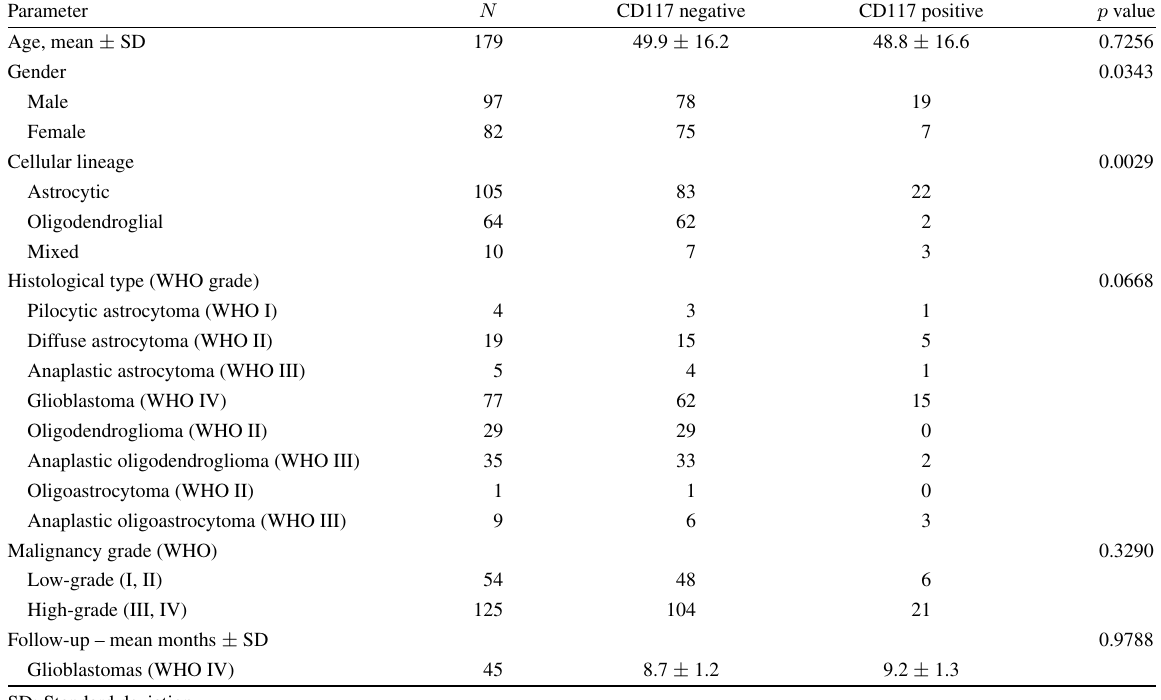
Clinical-pathological analysis of CD117 expression in gliomas